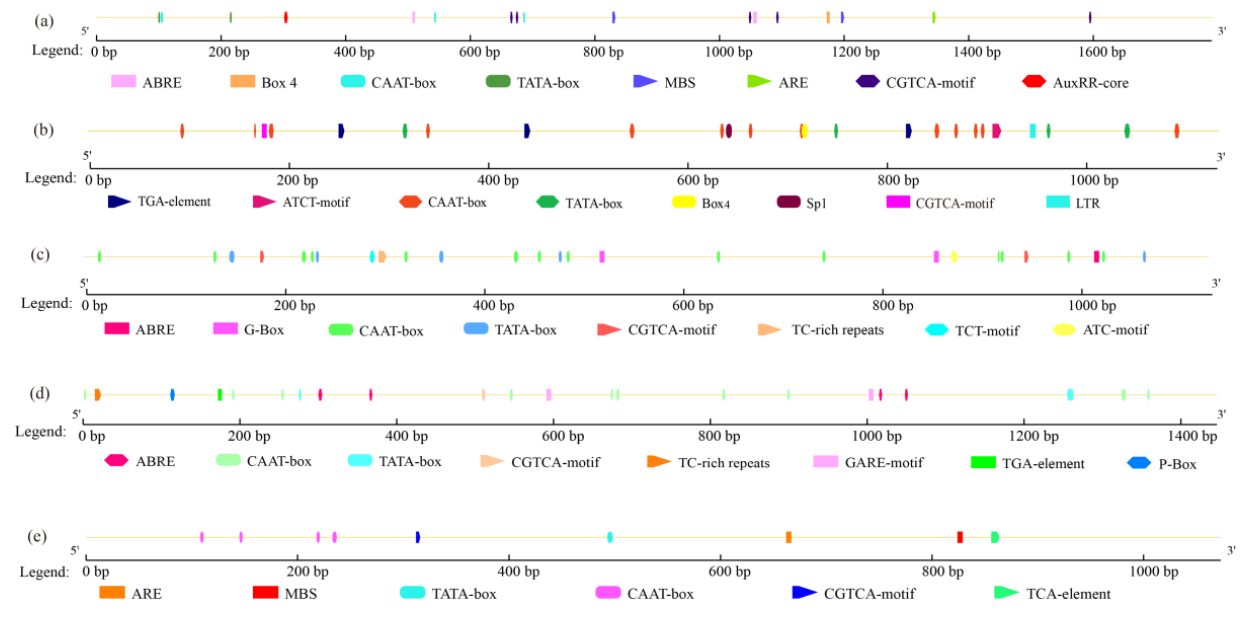
Figure 3. Major cis-acting elements and their positions in the promoter regions of five terpenoid biosynthesis genes. Schematic diagrams of the ( a ) HMGR gene promoter; ( b ) IDI gene promoter;